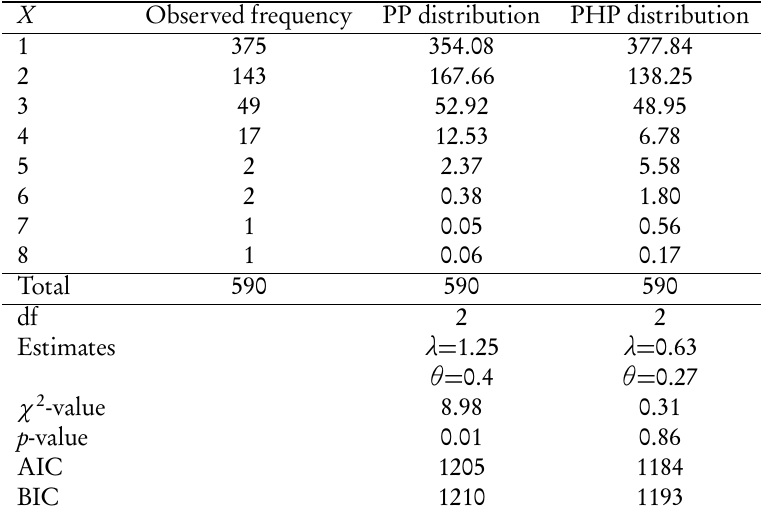
Distribution of number of households having at least one migrant according to the number of migrants, reported by Singh and Yadava (1981) and the expected frequencies computed using the positive Poisson and the PHP distribution.